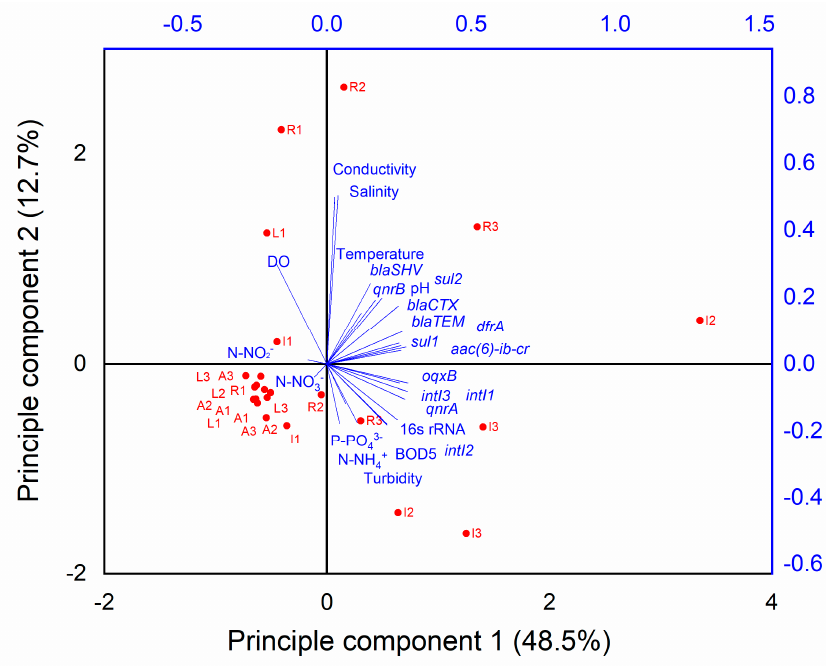
Figure 4. PCA analysis for all water quality parameters, ARGs, integrons, and 16S rRNA genes in all sampling sites along the Saigon River. sampling sites along the Saigon